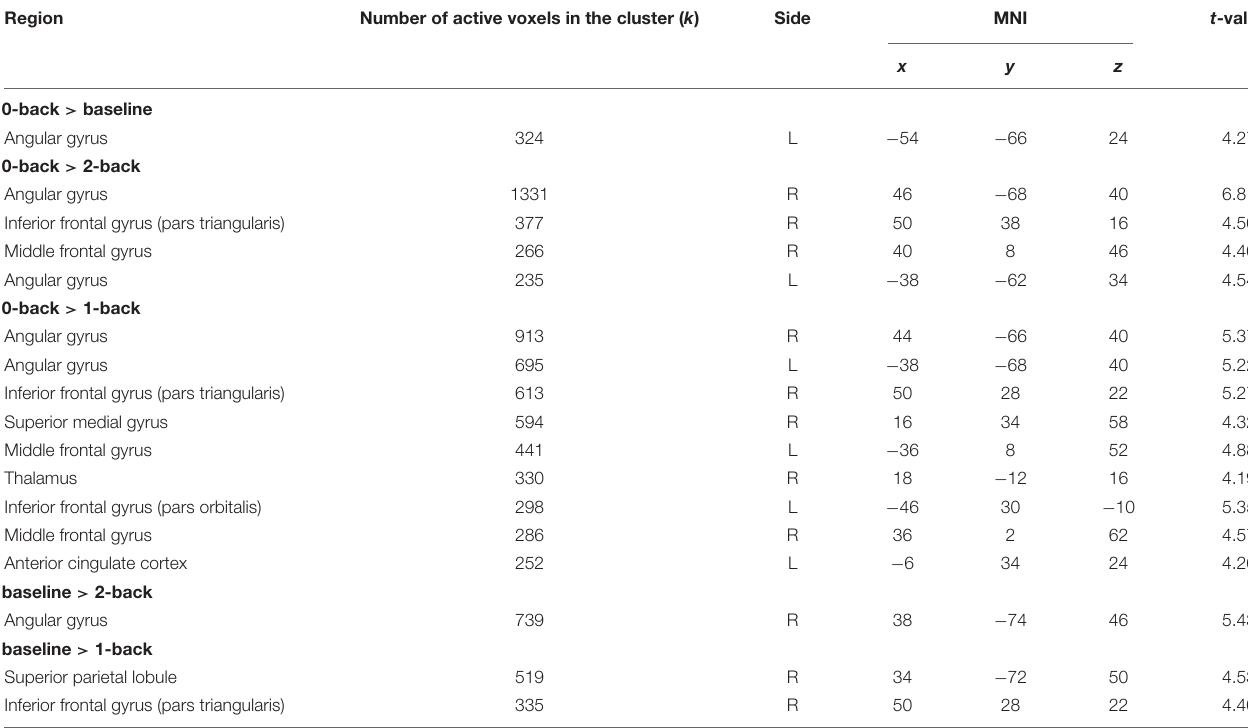
FIGURE 4 | Brain activation corresponding to the main effect of condition in n-back task: 2-back > 0-back. Highlighted areas are those that demonstrate more activation in the cognitively more challenging 2-back condition versus the cognitively less challenging 0-back condition. TABLE 6 | Interactions CF > NCF in n-back tasks between the two groups (chronic fatigue, no chronic fatigue) and the four different conditions of the n-back task (all p < 0.05 [familywise error rate (FWE)]-corrected; only the maximum peak in grey matter is reported for each cluster). Region Number of active voxels in the cluster ( k ) Side MNI t